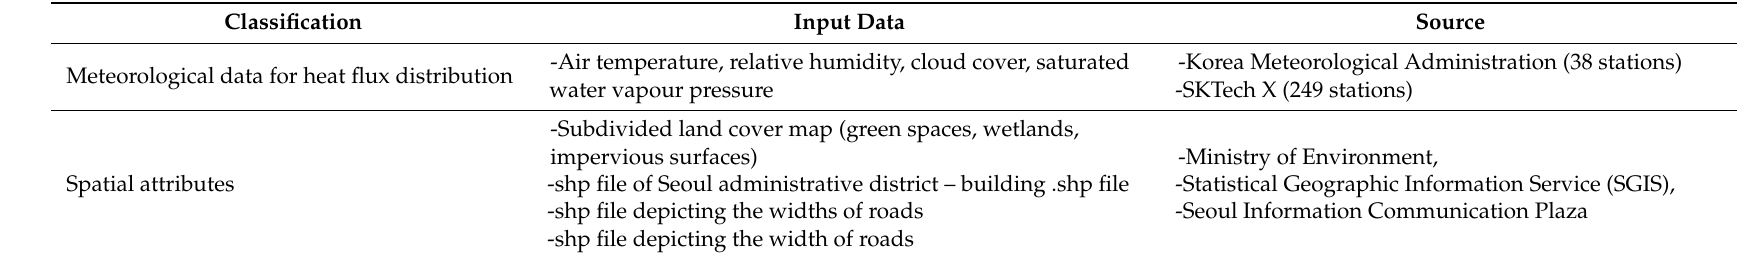
Table A3. Metrology and spatial attributes (land cover factors): data and sources.